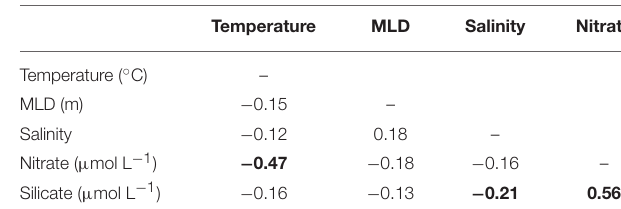
FIGURE 4 | niches (linear regressions, black line, p < 0.05). The relationship was non-significant (dashed line, p > 0.05) for temperature, mixed layer depth, and salinity (A–C) revealing close tracking of the mean or an extreme value of the environmental conditions for these variables. TABLE 4 | The correlation matrix between the five environmental variables for all observations between 1997 and 2013. Significant ( P < 0.05) correlations are in